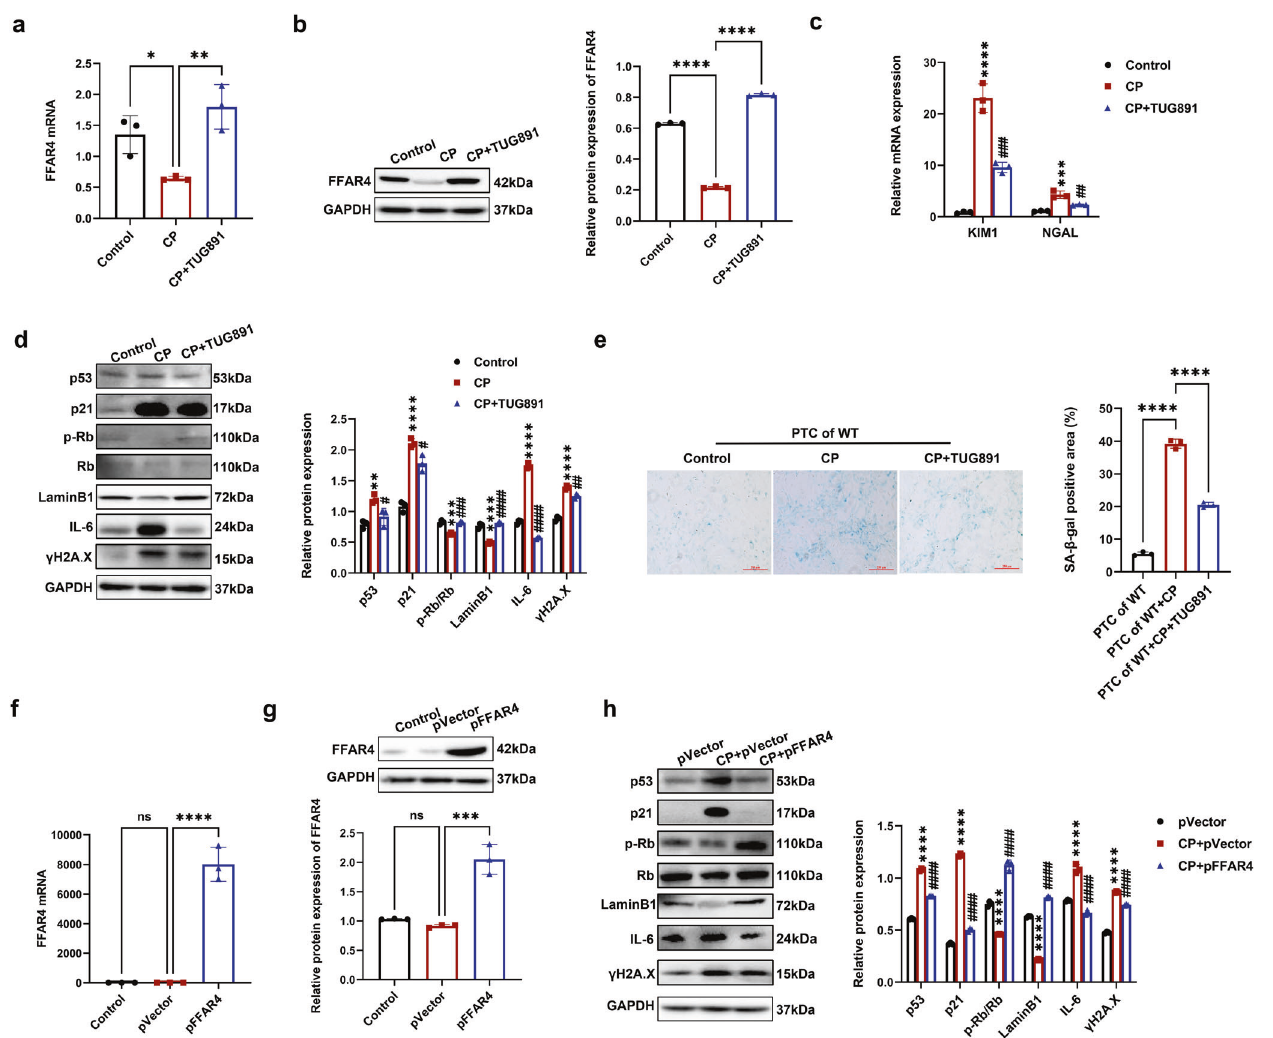
Fig. 5 Activation of FFAR4 improved cellular senescence in cisplatin-stimulated renal tubular epithelial cells. a , b Relative mRNA and protein expression of FFAR4 in TCMK-1 cells ( n = 3; **** P < 0.0001, ** P < 0.01, * P < 0.05). c Relative mRNA expression of KIM1 and NGAL in TCMK-1 cells ( n = 3; **** P < 0.0001, *** P < 0.001, CP vs. Control; ### P < 0.001, ## P < 0.01, CP + TUG891 vs. CP). d Protein expression of p53, p21, p-Rb/Rb, LaminB1, ɣ H2A.X and IL-6 in TCMK-1 cells detected by western blotting and quanti fi ed by densitometry ( n = 3; **** P < 0.0001, *** P <